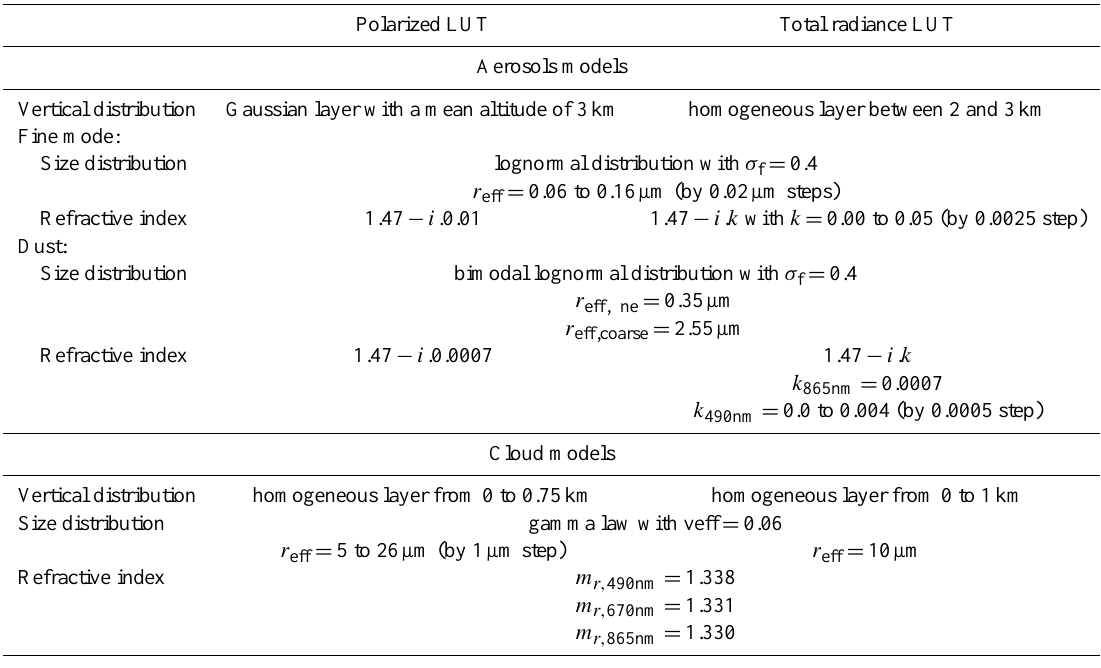
Table 1. Aerosol and cloud model properties used to compute the polarized and total radiance LUT of the POLDER algorithm. Polarized LUT Total radiance